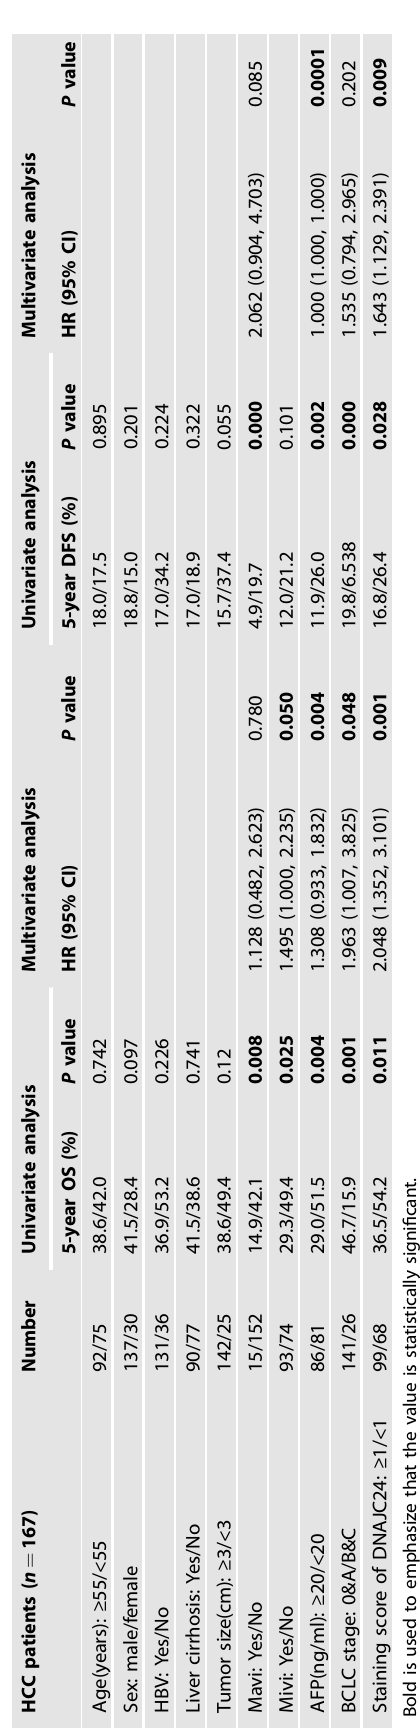
(Fig. S5E). We ampli fi ed the core promoter region of DNAJC24 and mutated 5 ’ -TTTTGGAACGTTT-3 ’ to 5 ’ -GGGGTTCCATGGG-3 ’ .